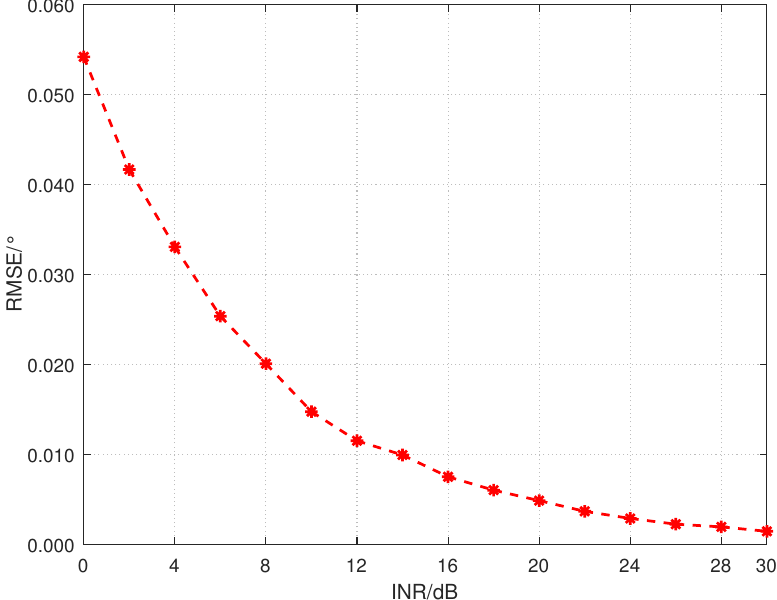
Figure 6. DOA estimation RMSE versus the input INR. Example 4. The output SINR versus with the input